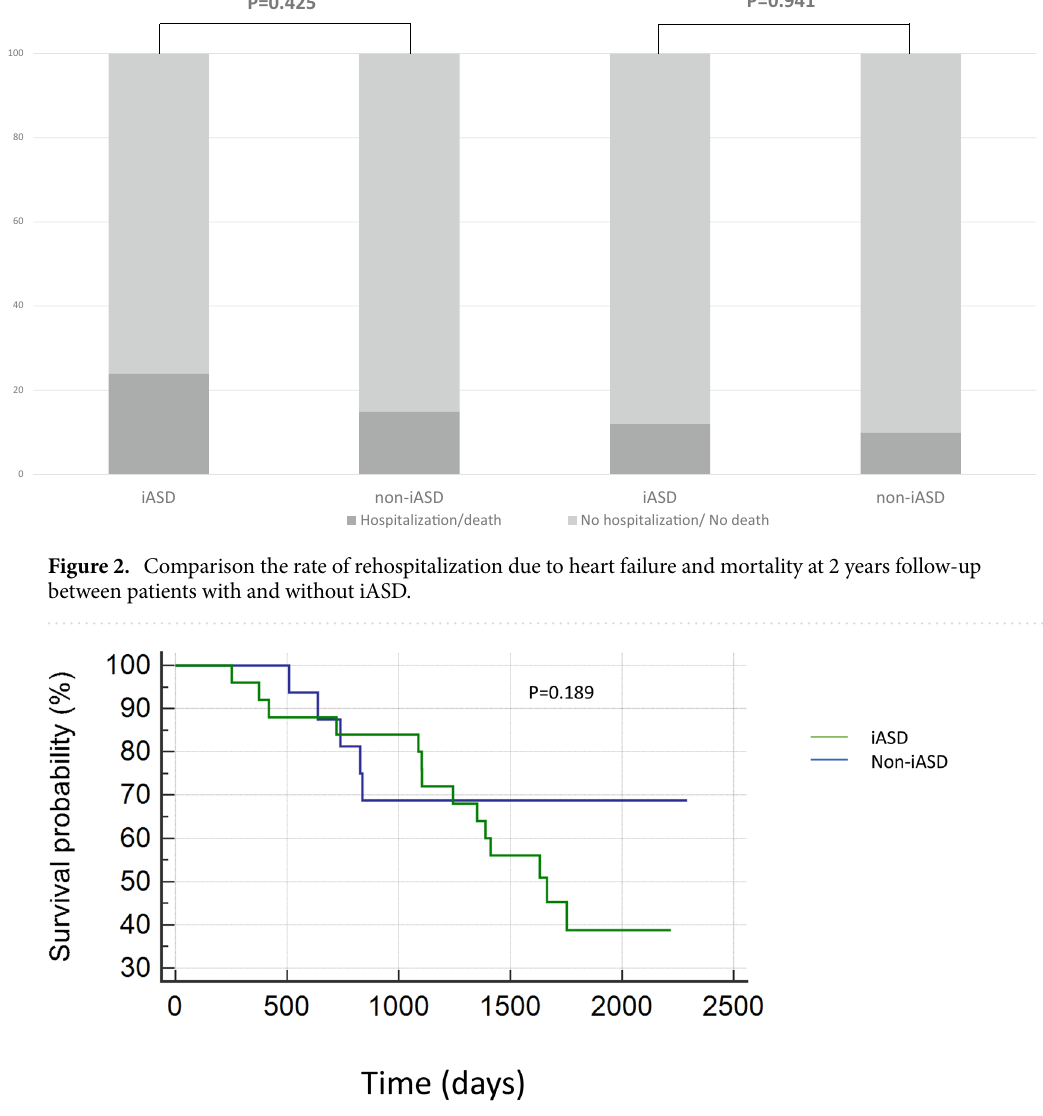
Figure 3. Kaplan Meier curve for survival in both groups at median follow-up of 4.3 ± 1.5